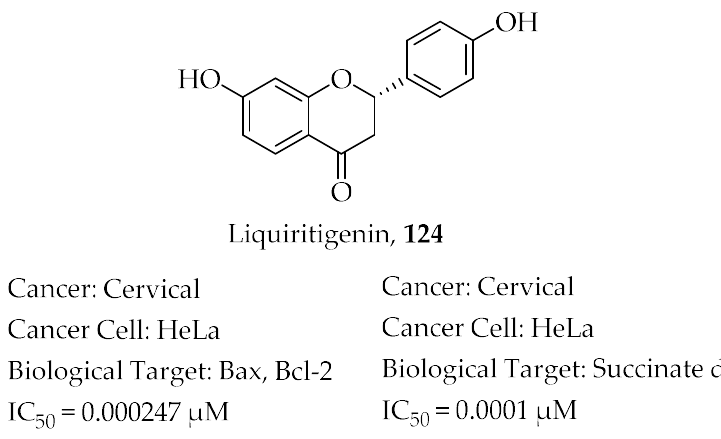
Figure 21. Structure of the 6-prenylated isoflavanone lipid Isoangustone A with a summary of its biological activity towards selected cancer targets. The antiproliferation mechanism of 125 has been studied in SW480 human colorectal adenocarcinoma cells [170], prostate cancer cells (PC3, LNCaP, DU 145, and 4 T1) [171,172] and melanoma cells (SK-MEL-2, SK-MEL-5, SK-MEL-28, WM-266-4 cell lines) [171]. Cell cycle arrest and apoptosis via the cessation of cyclin A, cyclin D, cyclin E, CDK2, and CDK4 protein expression and the downregulation of mTOR, PI3 K, Akt, and JNK were the major disrupted pathways identified [171]. Another component of the root of licorice is the isoflavonoid glabridin, 126 from the root of Glycyrrhiza glabra . Compound 126 inhibits cyclooxygenase activity and has an anti- inflammatory and an antiplatelet effect (Figure 22) [173]. Studies in modulating metastatic cascade have demonstrated the efficacy of com- pound 126 via interference of focal adhesion kinase (FAK), proto-oncogene-protein kinase (Src), protein kinase B (Akt), myosin, myosin light chain phosphorylation, and ras homo- log family member A (RhoA) with decreased expression and activities of MMP-9, phos- phorylation of ERK1/2 and JNK1/2 [174].